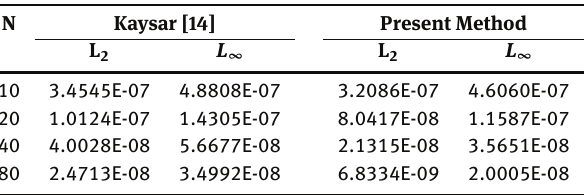
Table 11: Comparison of Errors in L 2 norm and L ∞ norm for different values of N , T = 1 , ν = 0.01 and Δt = 0.01 , corresponding to example-3.